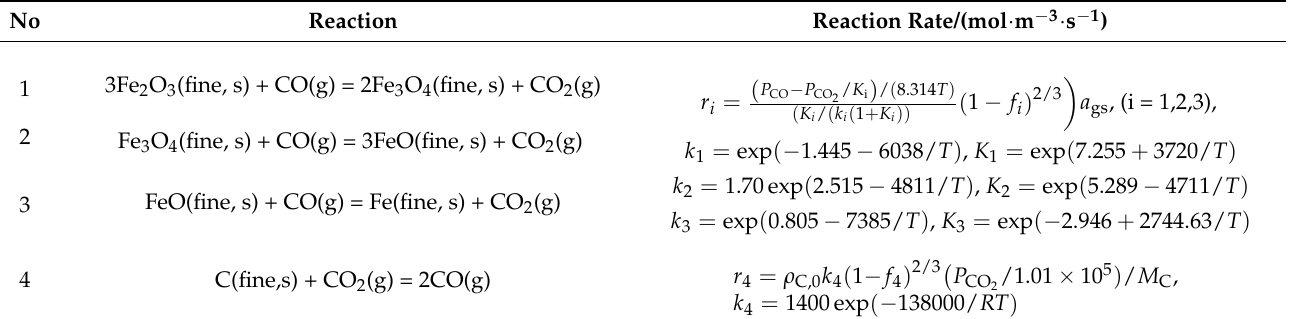
Table 6. Equations in CCB